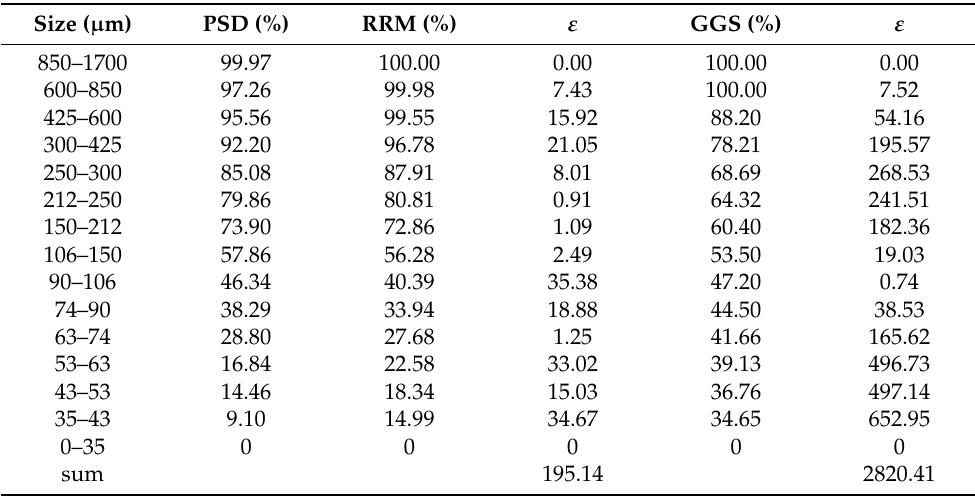
Table A4. Adjustment results of the PSD and PSDM with least squares, for 12 min.